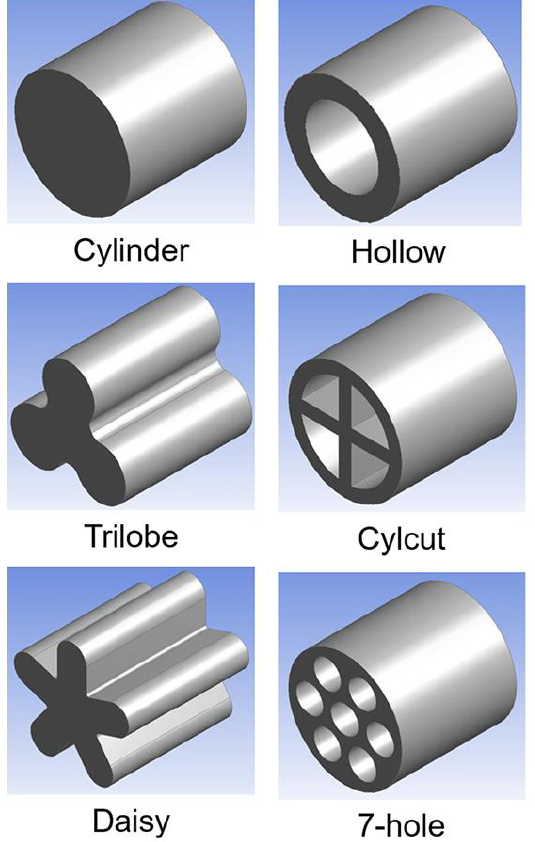
Figure 3. Packing shapes considered in the work of Buwa et al. [71].